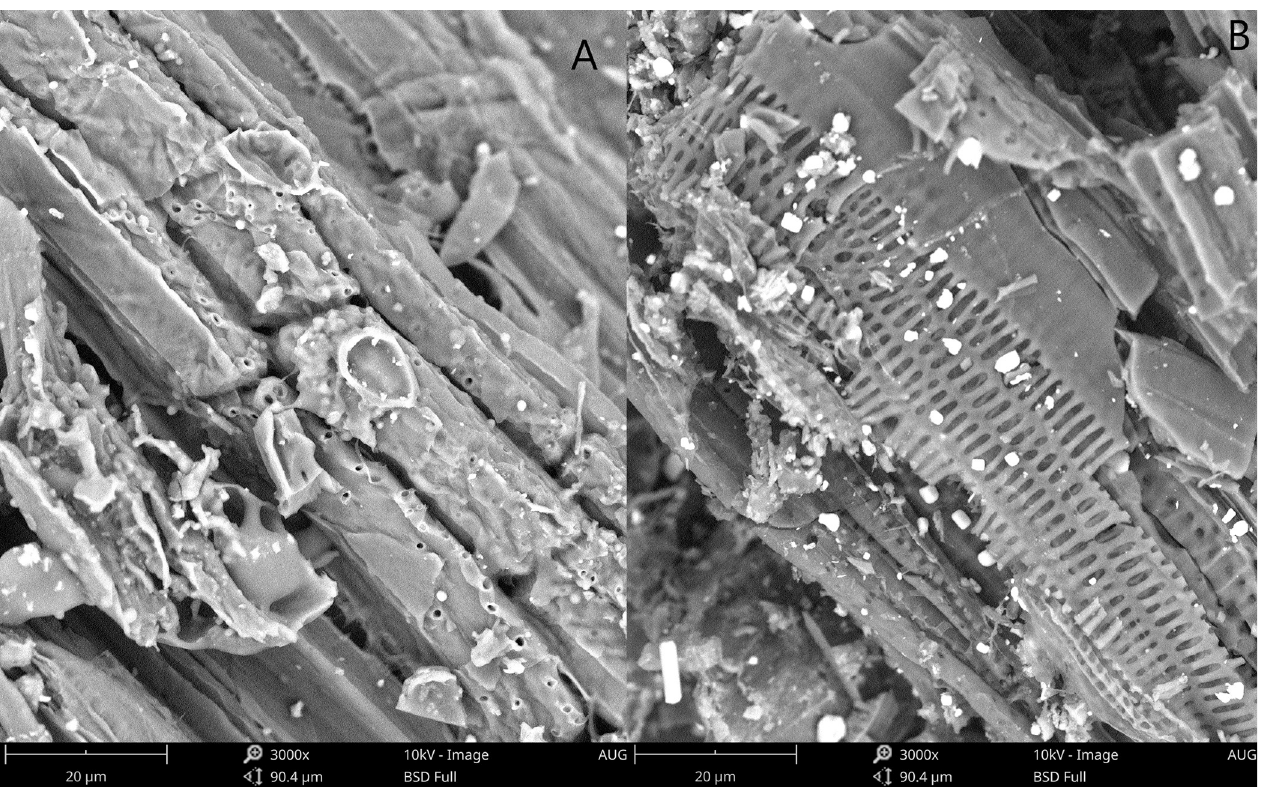
Fig 1. SEM images of B500 (A) and R500 (B) ( × 3000).